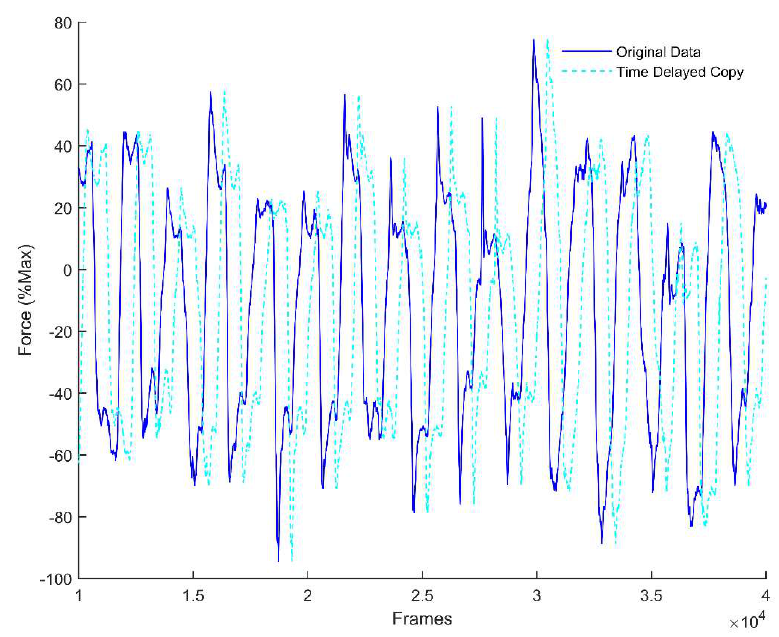
Figure 3. Original force profile (solid line) with a time delayed copy (dashed line).